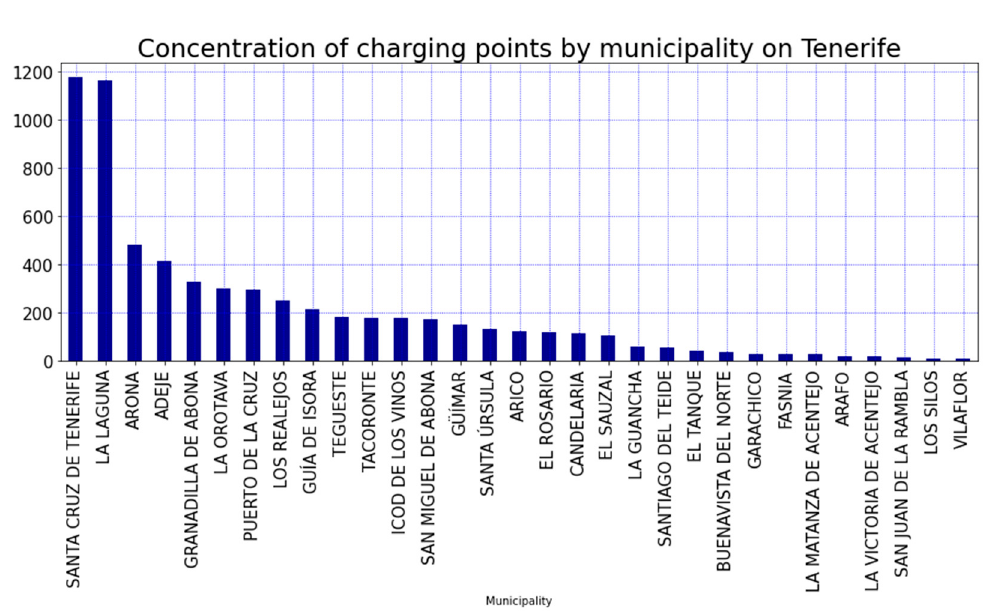
Figure 17. Concentration of charging points by municipality on the island of Tenerife in 2037.